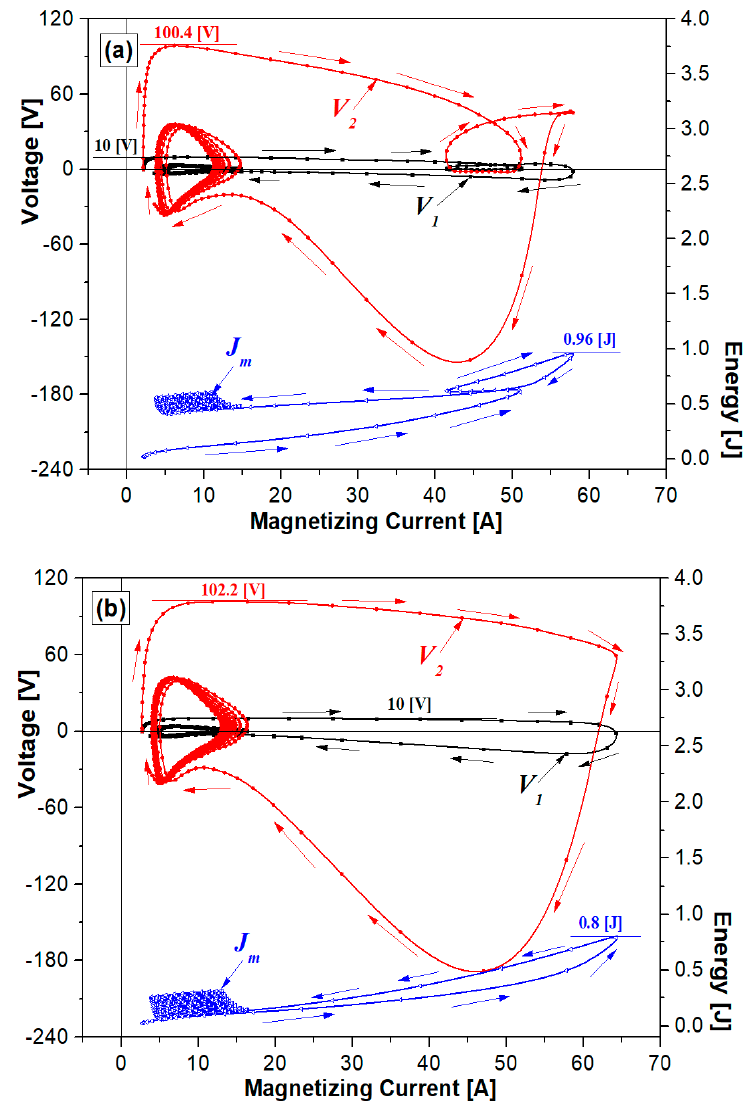
Figure 7. Variation of induced voltage and consumed energy of each winding due to magnetizing current ( i m ) during fault period in the bridge type SFCL using flux-coupling according to the change of input voltage source. ( a ) E in = 80 V rms . ( b ) E in = 100 V rms . Figure 8 shows the operating range of the magnetization power ( 𝑝 (cid:3040) ) and the magnetic flux linkage ( λ ) according to the magnetizing current during the fault period when the input voltage source changes to 80 V rms and 100 V rms , respectively. Referring to the equivalent circuit in Figure. 2, flux linkages ( λ 1 , λ 2 ) of the primary and secondary windings and magnetization power ( 𝑝 (cid:3040) ) can be redrawn on the axis by the magnetizing current as shown in Figure. 8. During the fault period, flux linkages 1 and 2 can be calculated as 𝜆 (cid:2869) = (cid:1516)𝑣 (cid:2869) 𝑑𝑡 , 𝜆 (cid:2870) = (cid:1516)𝑣 (cid:2870) 𝑑𝑡 , and the magnetization power can be obtained by calculating 𝑝 (cid:3040) = 𝑣 (cid:2869) 𝑖 (cid:3040) . Therefore, as shown in Figure 8, it is possible to obtain a relationship curve between magnetization power and flux linkage according to the magnetizing current. As the input voltage source increases, the maximum magnetization power is 0.17 kW higher,